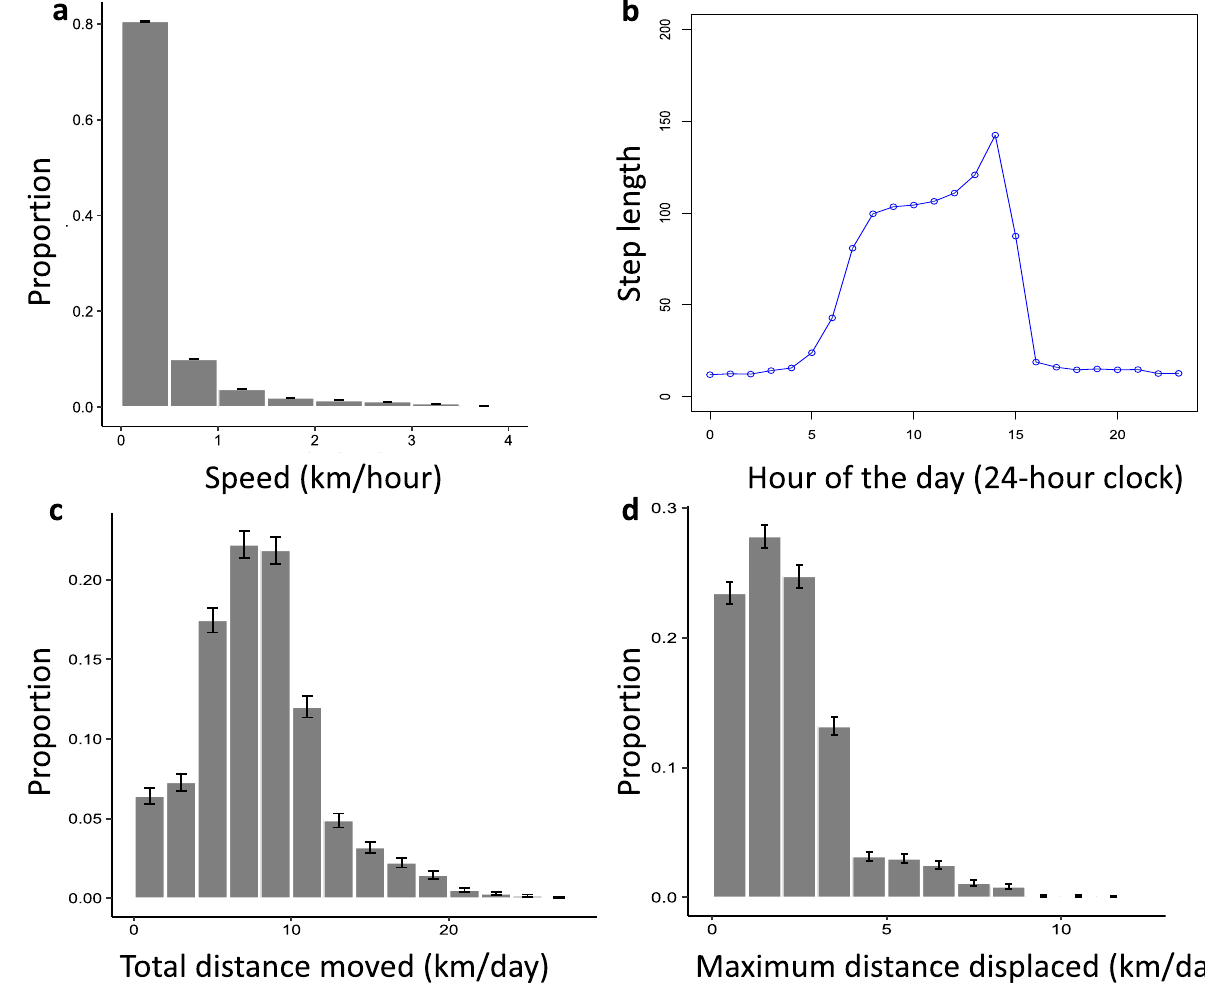
Figure 2. Speed, timing and distance of movements observed among collared cattle. ( a ) The speed cattle moved during the study period; ( b ) the median step length across the day (i.e. median distance moved every 15 min within the hour); ( c ) the total daily distance GPS collared cattle moved (i.e. the sum of the distance of all 15-min relocation intervals); and ( d ) the maximum daily distance cattle were displaced from their home bomas. Error bars denote standard error of the